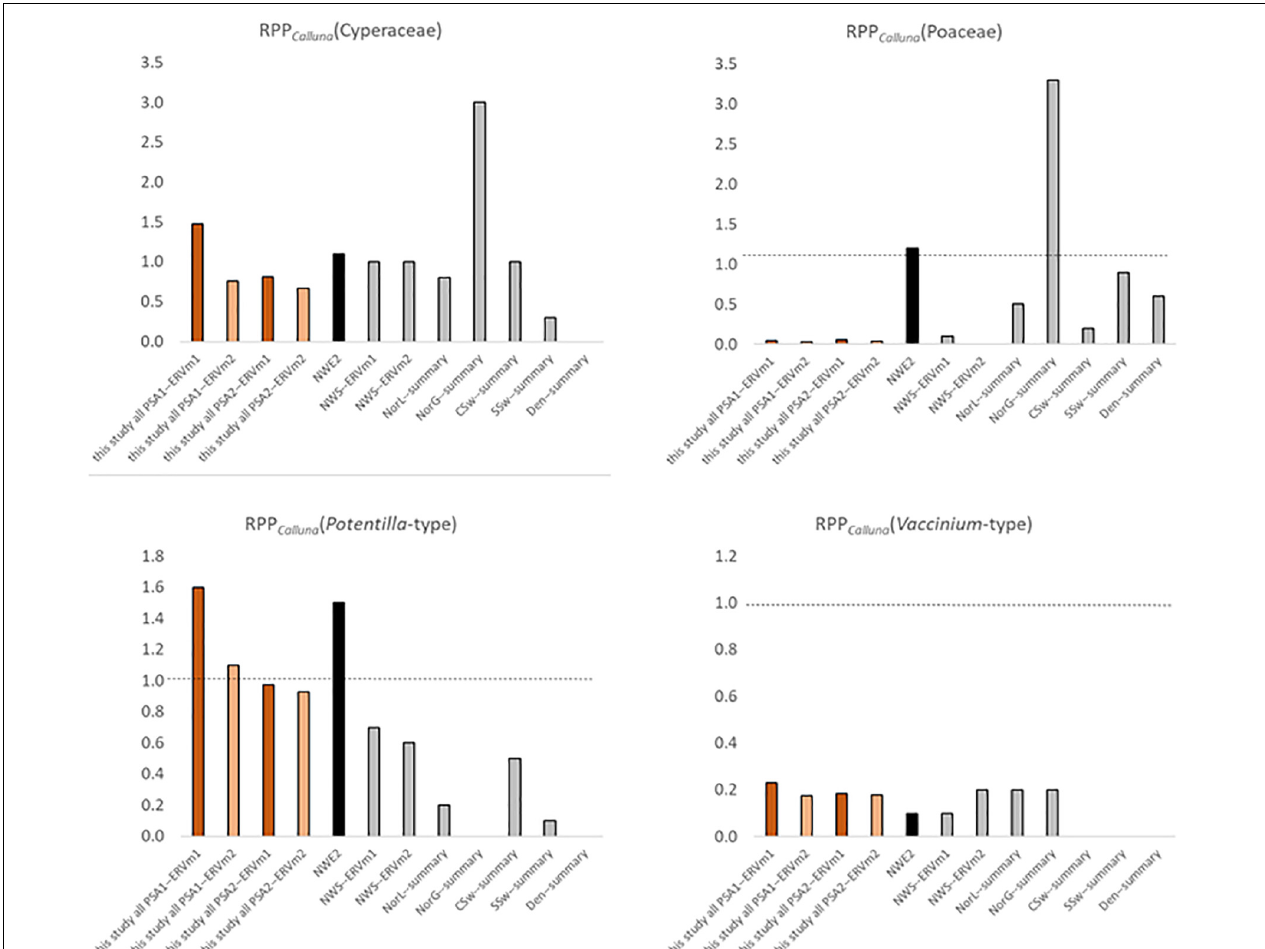
FIGURE 8 | Comparison of Pollen Productivity relative to Calluna vulgaris for heathland taxa from multiple studies (see Table 1 for more details). Orange bars—this study, black—north-west European PPE.st2 values (Mazier et al., 2012), grey—single region studies ( Table 1 ). Dashed line at 1.0, note varied y-axis scales, and x indicates that a taxon was not included in the original